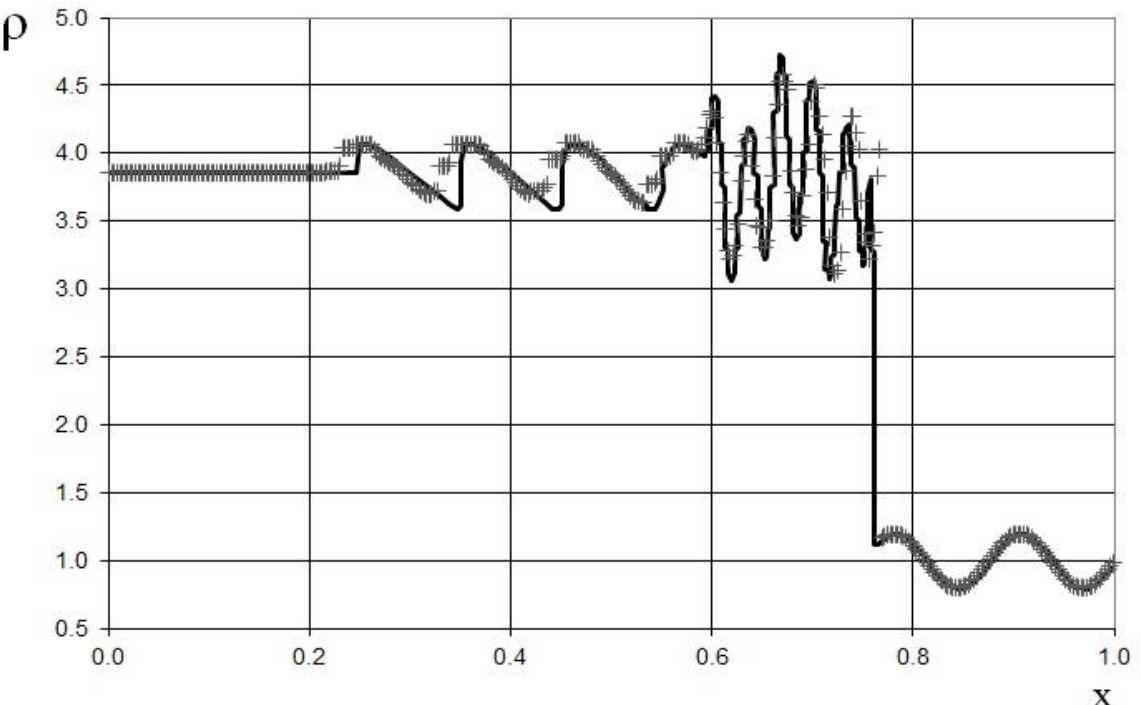
Figure 23. Density plot for the Shu – Osher shock-tube problem, using the coarse grid (192 grid points): the “exact” solution [4 4] (line), and the present method (cross).